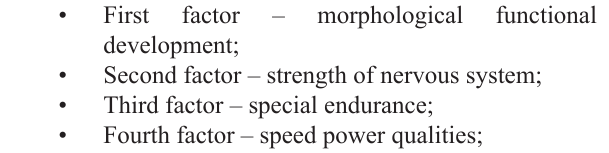
Table 2. Examples of individual values of athletes’ factors (main staff of team) Factors Athlete’s №